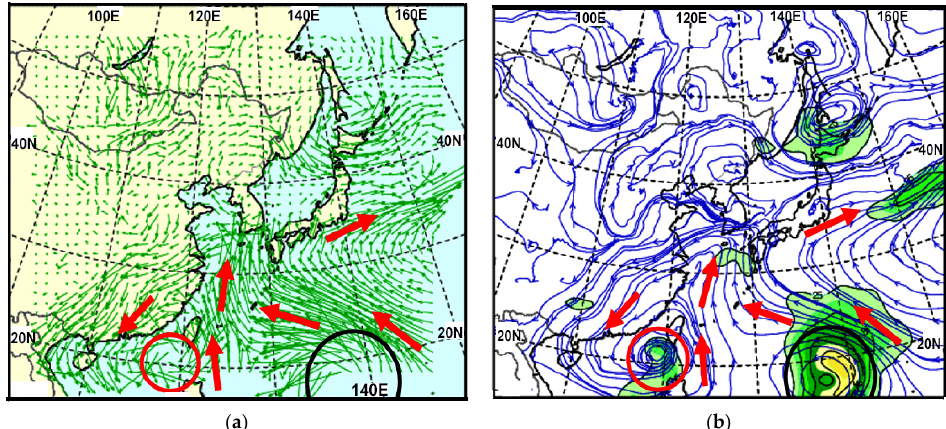
Figure 13. As shown in Figure 4, except for ( a ) moisture flux (0.1 m/s) and ( b ) streamline with isotaches at 09:00 LST, 7 July. STS Linfa develops by the intensified TY Chan ‐ Hom pulled by the MLCT.